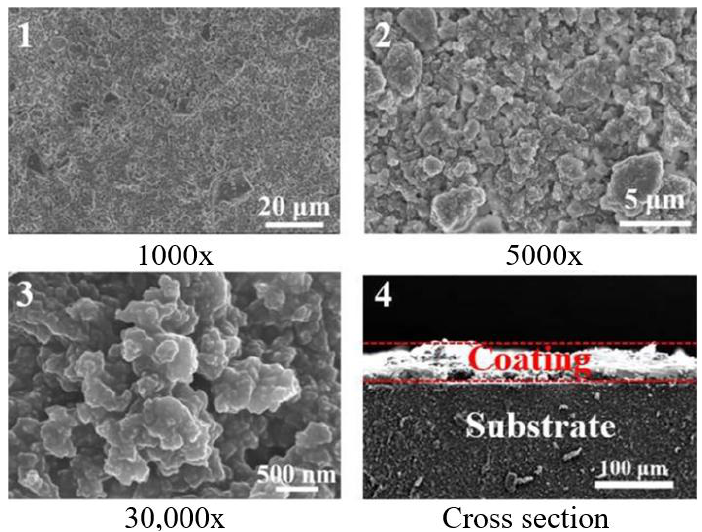
Figure 11. SEM images of nano-coated SiR samples at various magnifications (1 – 3) and the cross- sectional morphology [71].